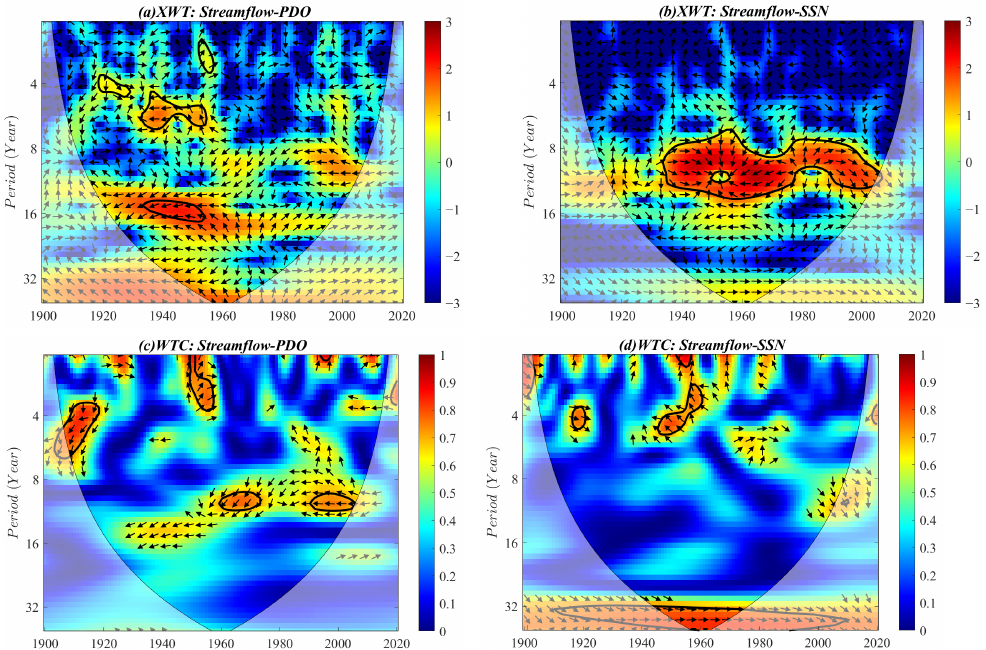
Figure 11. Cross-wavelet and wavelet coherence spectrums between annual streamflow series and PDO/SSN. ( a ) XWT: Streamflow-PDO; ( b ) XWT: Streamflow-SSN; ( c ) WTC: Streamflow-PDO; ( d ) WTC: